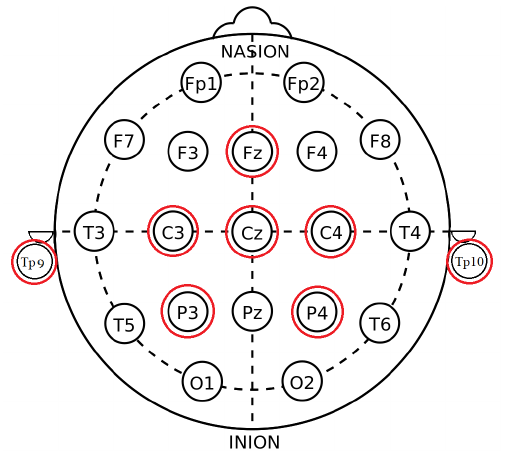
Figure 2. Electrodes’